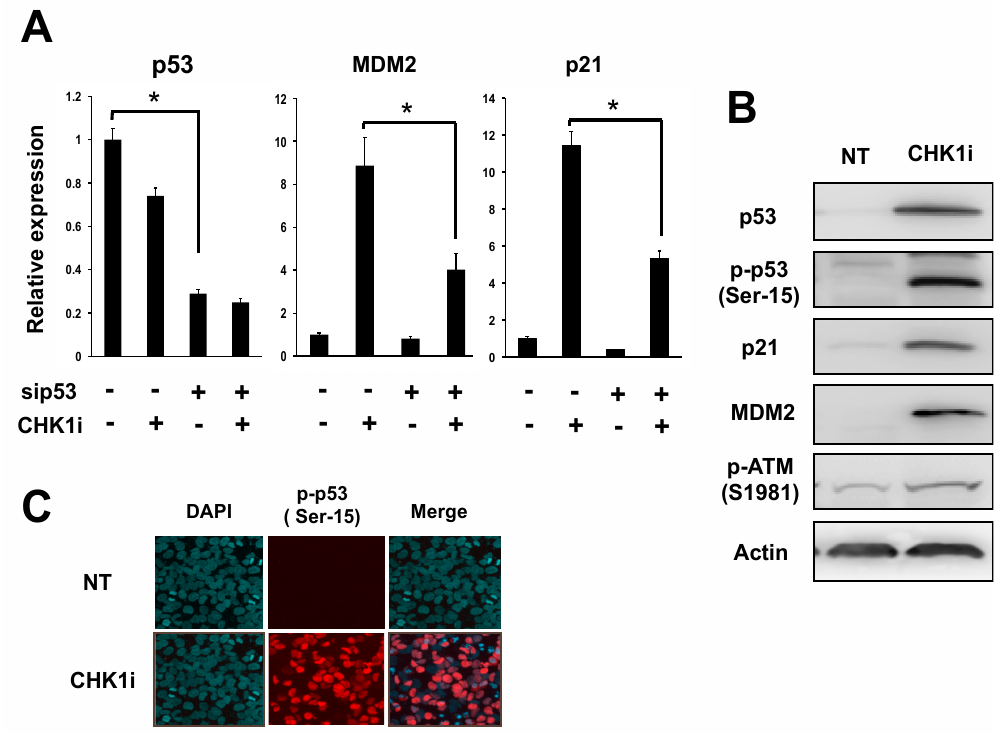
Figure 2. CHK1 inhibition activates the ataxia telangiectasia mutated serine / threonine kinase (ATM)-p53-p21 axis of the DNA damage response (DDR) pathway. ( A ) Quantitative RT-PCR analysis of p53, MDM2, and p21 mRNA levels in NB-39-nu cells transfected with 10 nM p53-specific or control siRNA for 24 h and then treated with 1 µ M CHK1i (PF-47736) or DMSO for 24 h. Data are presented as the mean ± SD of triplicates and are normalized to ACTB levels. * p < 0.05. ( B ) Immunoblot analysis of the indicated proteins in NB-39-nu cells treated for 24 h with 1 µ M CHK1i or DMSO (NT). β -actin was used as a loading control. ( C ) Indirect immunofluorescence of NB-39-nu cells treated for 24 h with 1 µ M PF-477736 or DMSO. Cells were stained with polyclonal anti-p-p53-Ser15 (red) and 4 (cid:48) ,6-diamidino-2-phenylindole (DAPI, nuclear DNA,